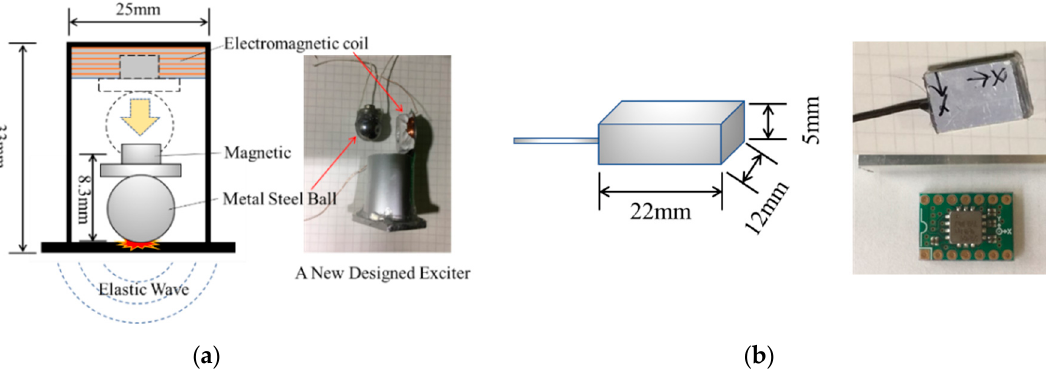
Figure 4. Newly designed exciter and receiver: ( a ) The newly designed exciter is used to generate pulse elastic waves. It has a height of 33 mm and a width of 25 mm. The mass of the steel ball is 16.95 g. It can be pulled up by the electromagnet and freefalls from a height of 8.3 mm when the electromagnet is released. ( b ) The receiver has a height of 5 mm, length of 22 mm, and width of 12 mm. A MEMS three axle accelerometer is inside.